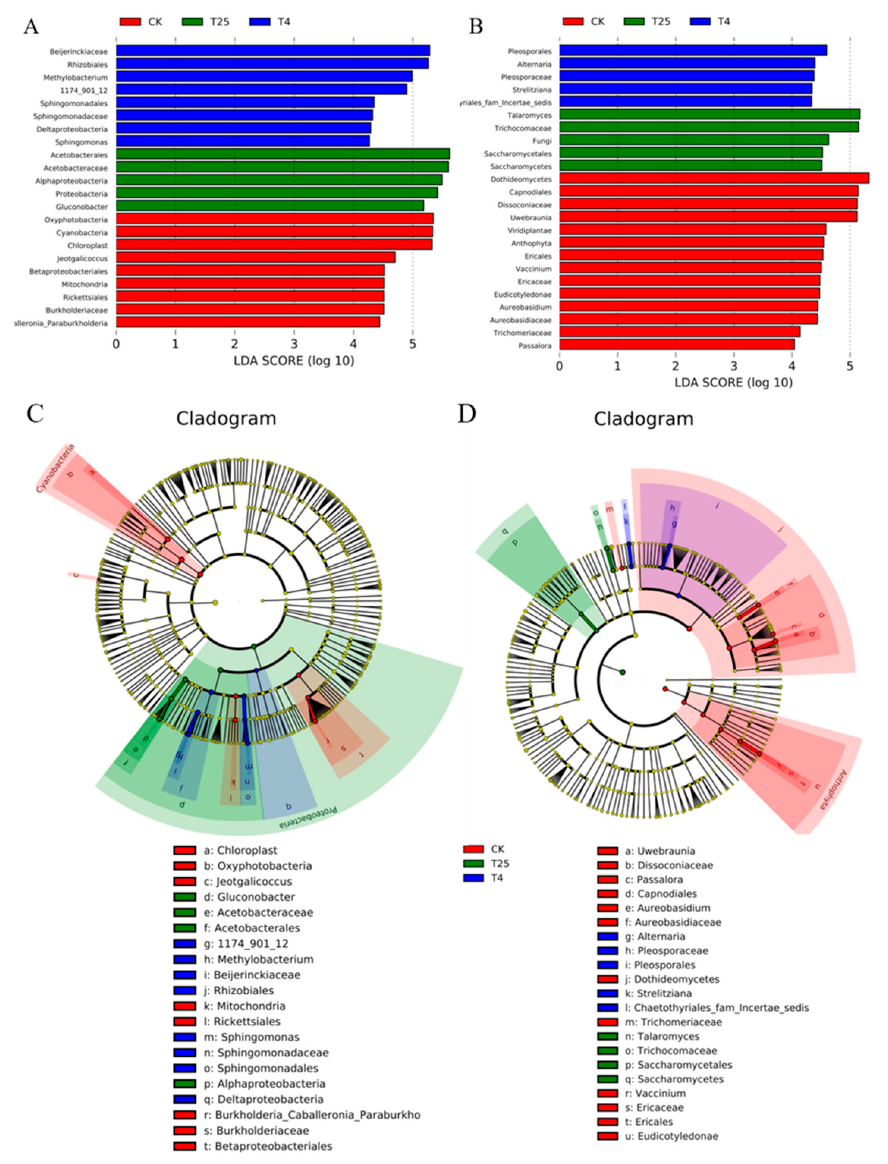
Figure 5. LEfSe analysis illustrating the differences in the relative abundance of taxa on the blueberry surface at different storage temperatures. The linear discriminant analysis (LDA) histogram exhibits biomarkers of fungal microbiota on the blueberry surface. The histogram shows taxa with significant differences (cut-off score ≥ 2.0). The cladogram was with significantly discriminant taxon nodes in different colors. Red and green circles mean that the taxa showed differences in relative abundance, and yellow circles mean non-significant differences; branch areas are shaded according to the highest ranked group for that taxon. ( A , C ): bacteria, ( B , D ):